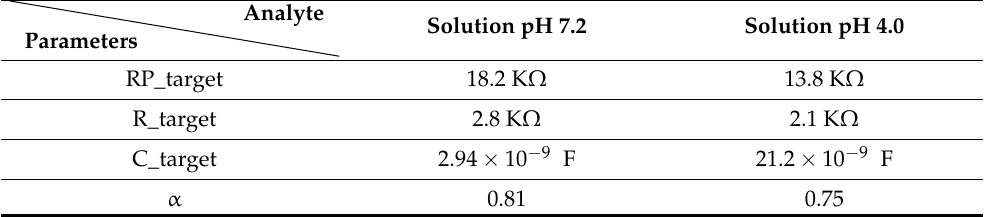
Figure 3. The modified Cole-Cole model using the extracted parameters in Table 1 for ( a ) analyte solution from pH 7.2 and ( b ) analyte solution from pH 4.0 in respectively. The model predicts a well agreement with commercial impedance measurement instrument HIOKI IM3536. Table 1. The parameter lists of modified Cole-Cole model and extraction results in solution of pH 7.2 and pH 4.0. α is a dispersion coefficient evaluating the relaxation time constants in an